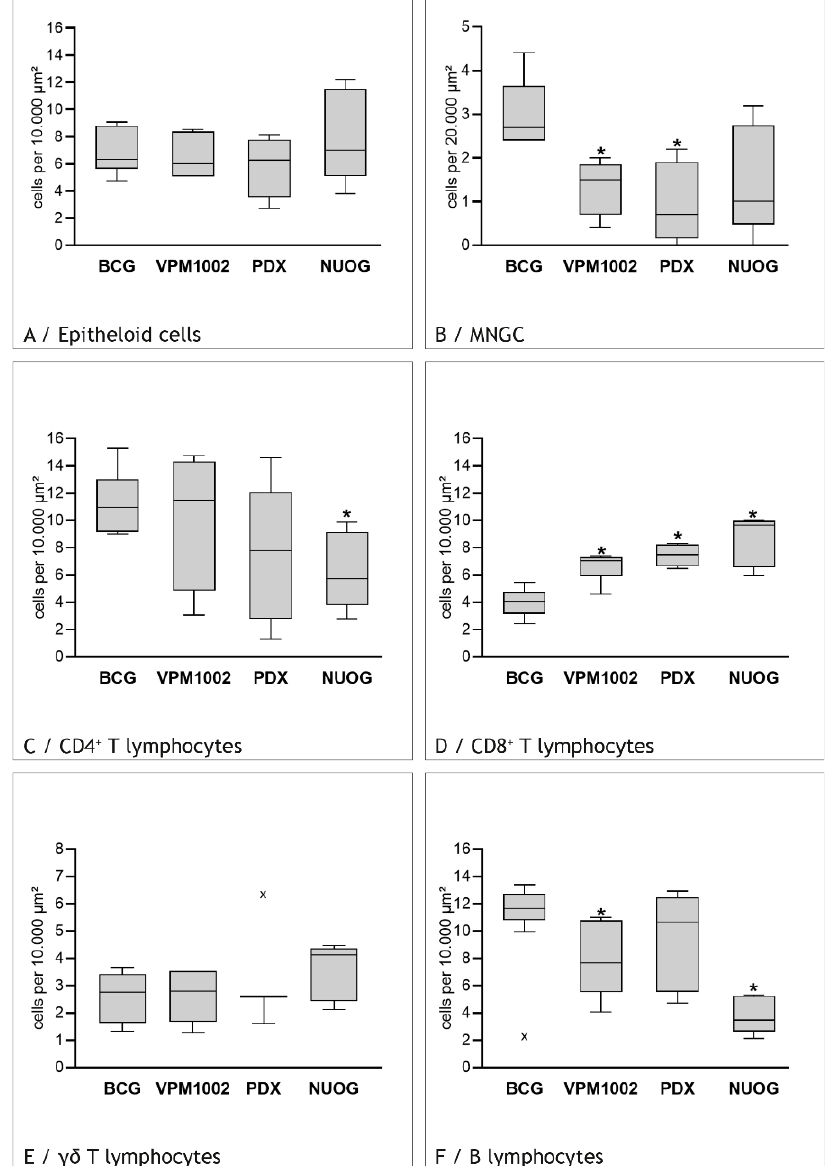
Figure 11. Composition of inflammatory cell infiltrates in BCG-, VPM1002-, PDX- and NUOG-induced granulomas. Each column represents 6 goats, with 15 reference areas counted per goat. Interquartile range (IQR, grey box), median (line) as well as maximum and minimum (whiskers) are indicated. x outliers, more than 1.5 IQR below first quartile or above third quartile, * significant differences ( p < 0.05) from BCG-induced granulomas.